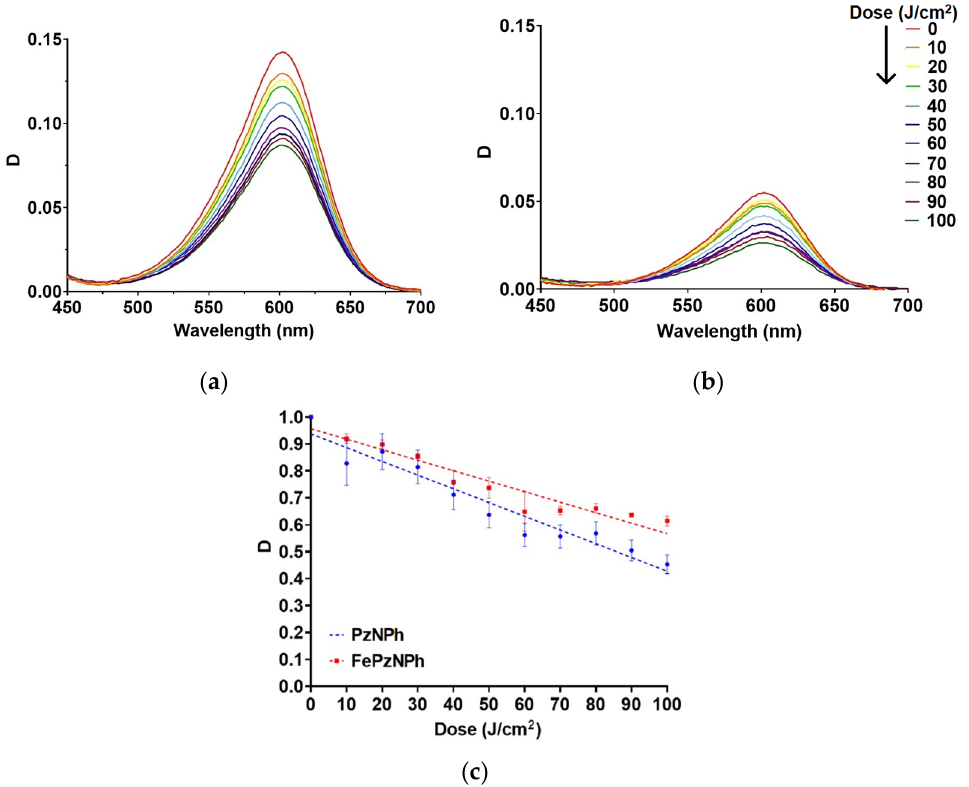
Figure 3. Photobleaching of PzNPh and FePzNPh in the glycerol solution under irradiation; ( a )—Absorption spectra of PzNPh after irradiation; ( b )—Absorption spectra of FePzNPh after irradiation; ( c )—The dose-dependent decrease in optical density at the absorption maximum for PzNPh and FePzNPh . The data are presented as the mean values ± SD ( n = 3).